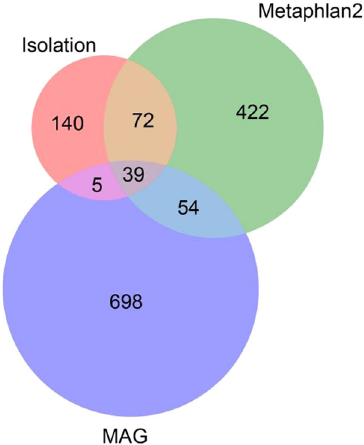
Fig. 8 Venndiagram on species identi fi ed by metagenomics (metaphlan2 and MAG algorithms) or